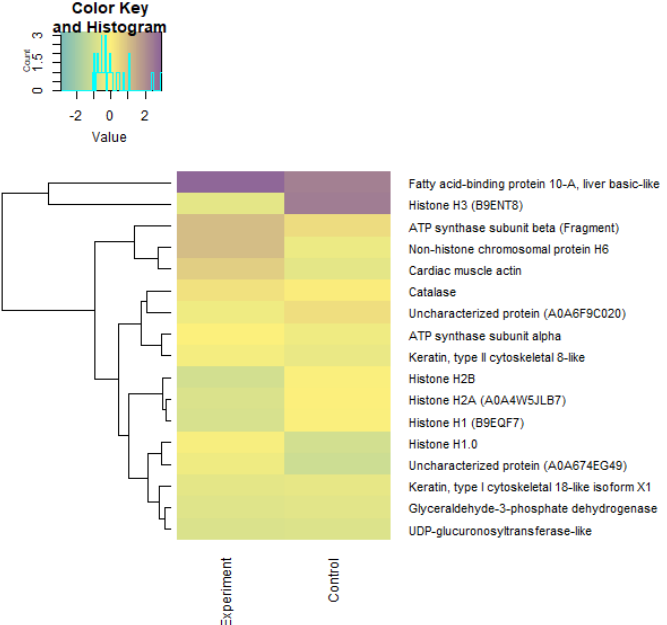
Figure 14. Heatmap LFQ Z-scores of normalized data of a “mean concentration” proteome (group 2) in underyearlings of Atlantic salmon ( Salmo salar L.) for control and experimental groups. Biomolecules 2022 , 12 , 133